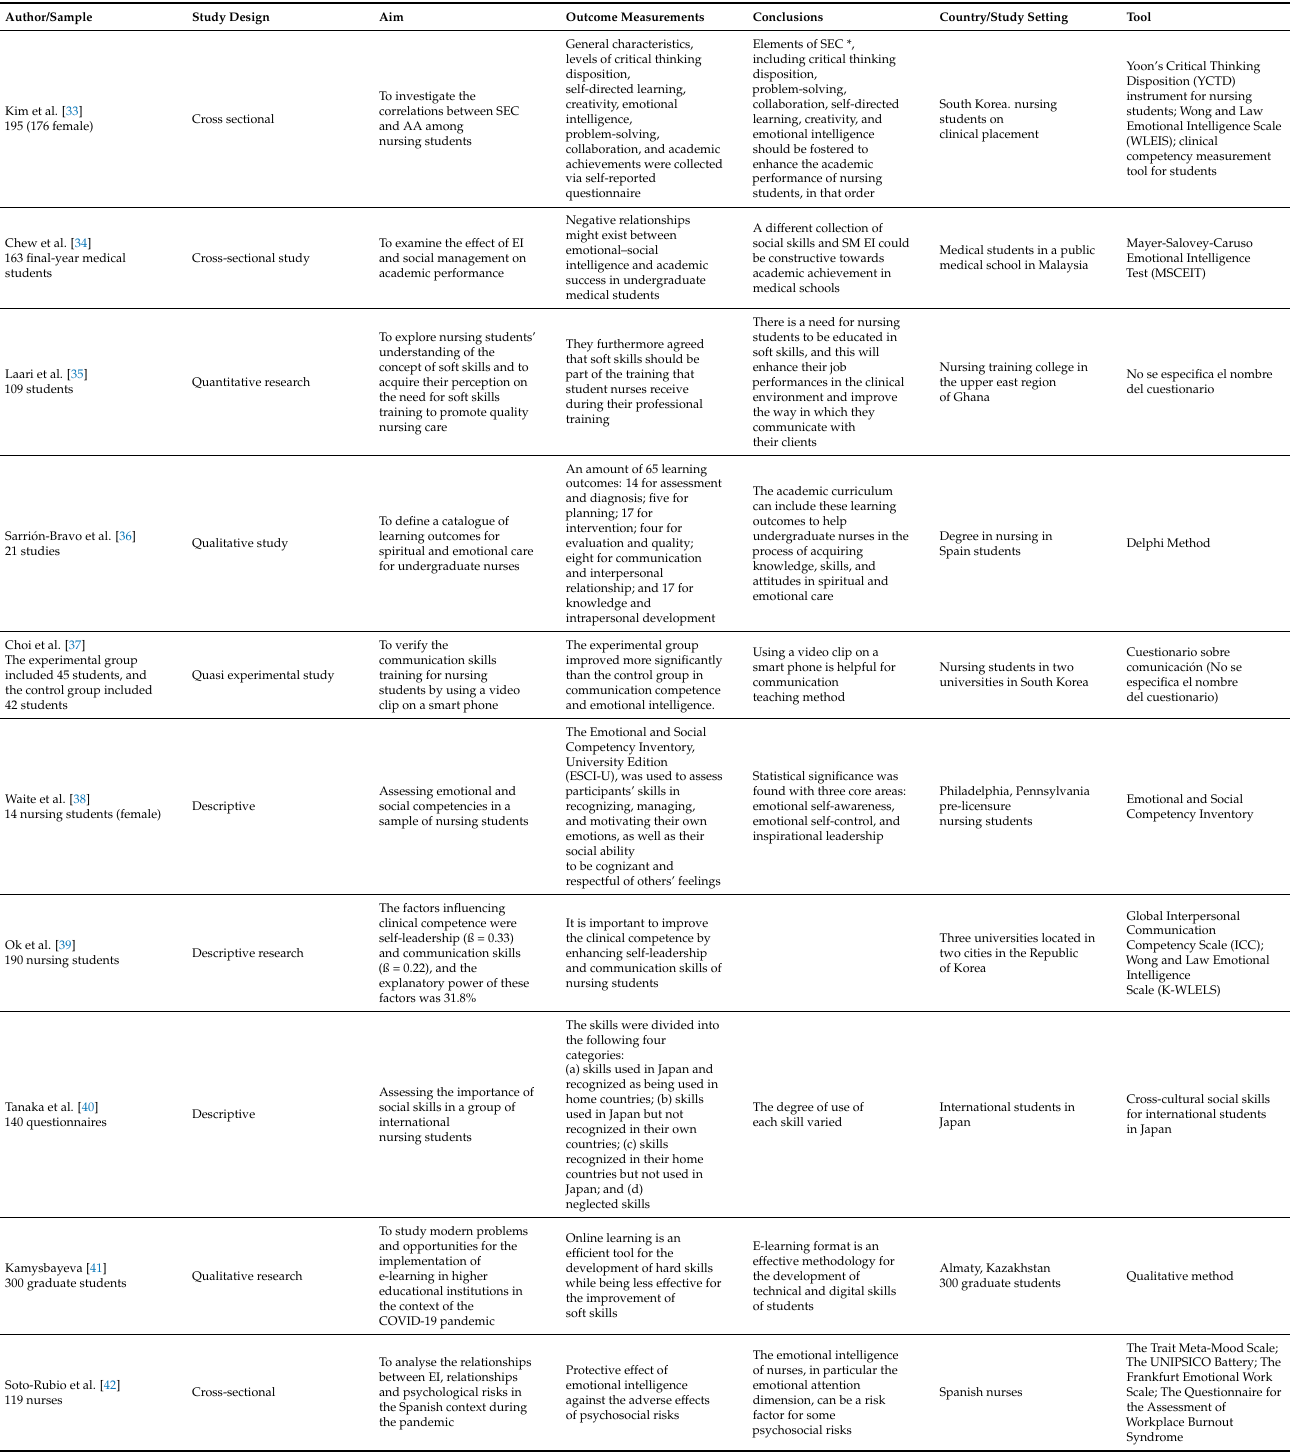
Table 2. Importance of soft skills in nursing after the COVID-19